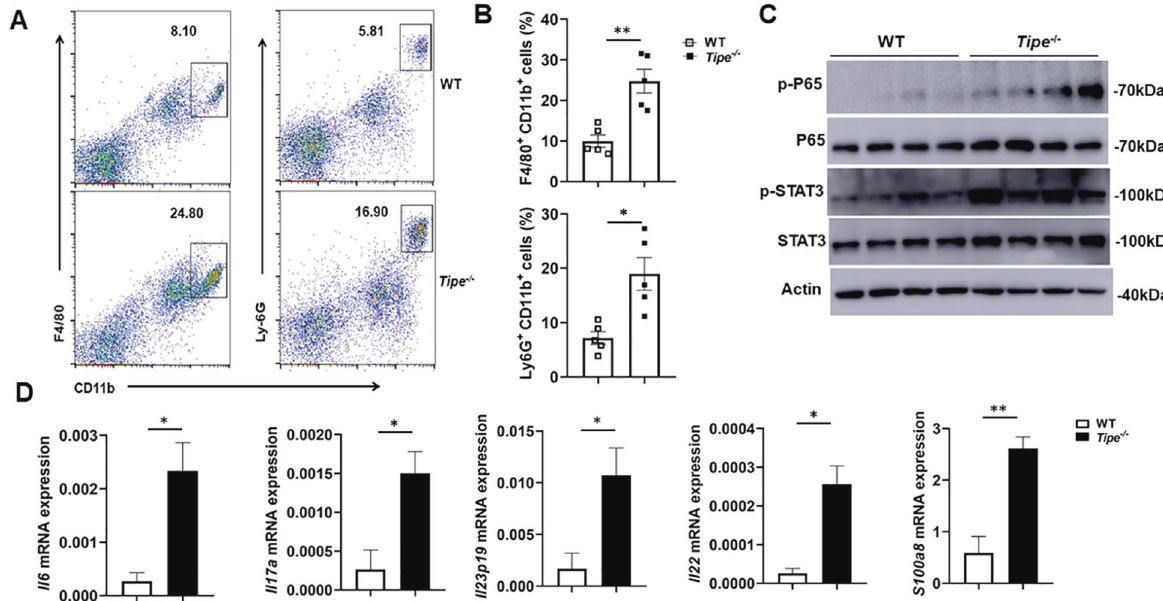
Fig. 2 The in fl ammation is increased within colon tumors of Tipe − / − mice. A Flow cytometic dot plot analysis of CD45 + F4/80 + CD11b + cells and CD45 + Ly-6G + CD11b + cells in colon tumor tissues from WT ( n = 5) and Tipe − / − ( n = 5) mice on day 90 of the CAC model. B Quanti fi cation of CD45 + F4/80 + CD11b + cells and CD45 + Ly-6G + CD11b + cells in colon tumor tissues as described in ( A ). C Western blot analysis of p-P65 and p-STAT3 in the colon tumor tissues of WT ( n = 4) and Tipe − / − ( n = 4) mice on day 90 of the CAC model. Blots represent data from the same biological samples run in parallel. D Quanti fi cation of in fl ammatory genes Il6 , Il17a , Il22 , Il23p19 and S100a8 mRNA expression by quantitative real-time PCR in the colon tumor tissues of WT ( n = 5) and Tipe − / − ( n = 5) mice on day 90 of the CAC model. Data are presented as mean ± SEM and are representative of three independent experiments. Student ’ s t test ( B , D ), * p < 0.05, ** p <